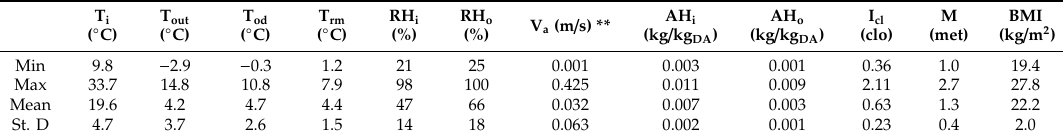
Table 2. Descriptive statistics of the collected data at times of